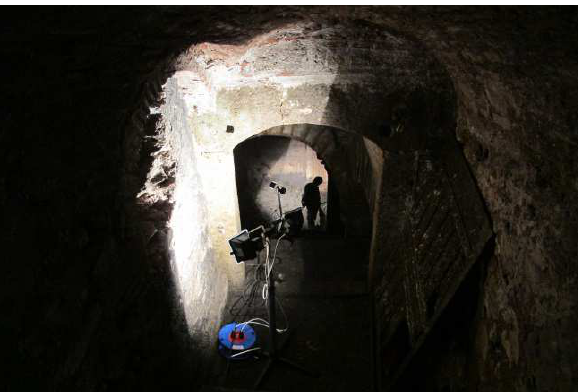
Figure 10-a. Working conditions inside the cistern